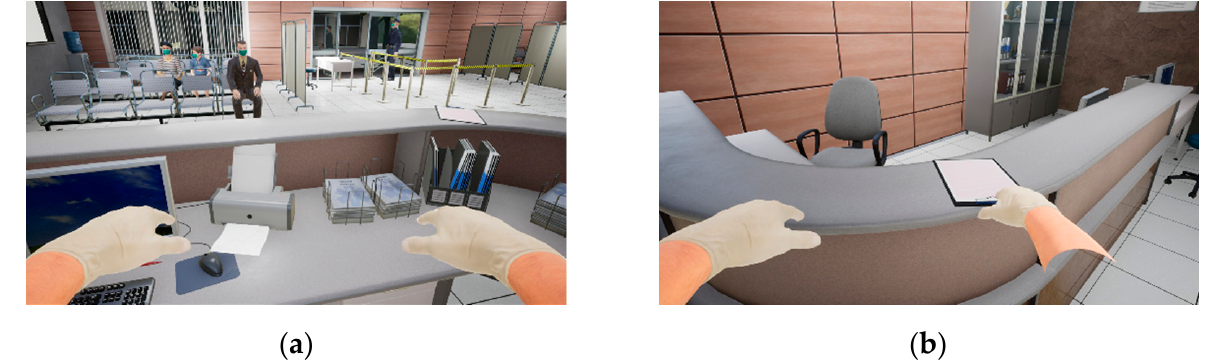
Figure 1. The VR education System: ( a ) 3D Environment; ( b ) Interaction with tools.